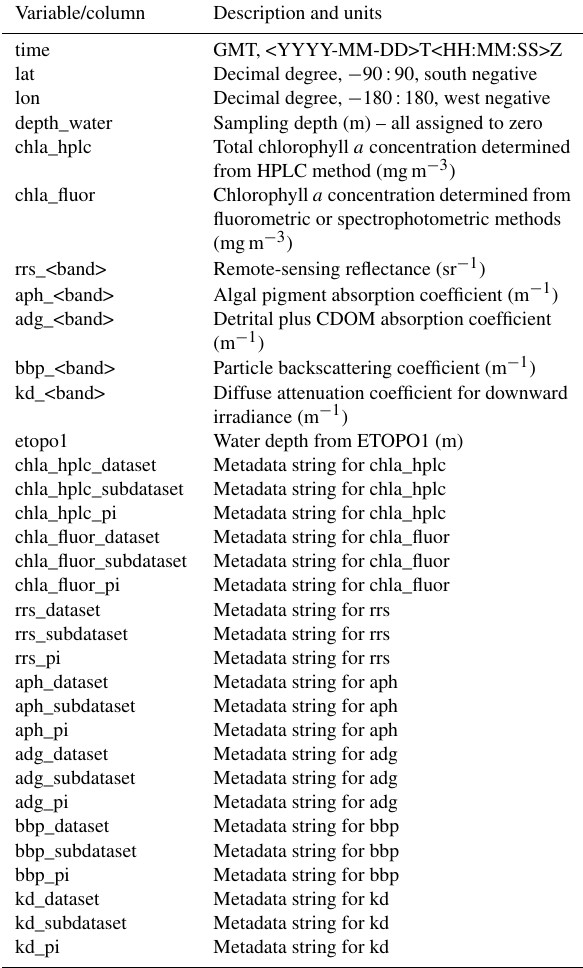
Table 1. The standard variables, nomenclatures and units in the fi- nal